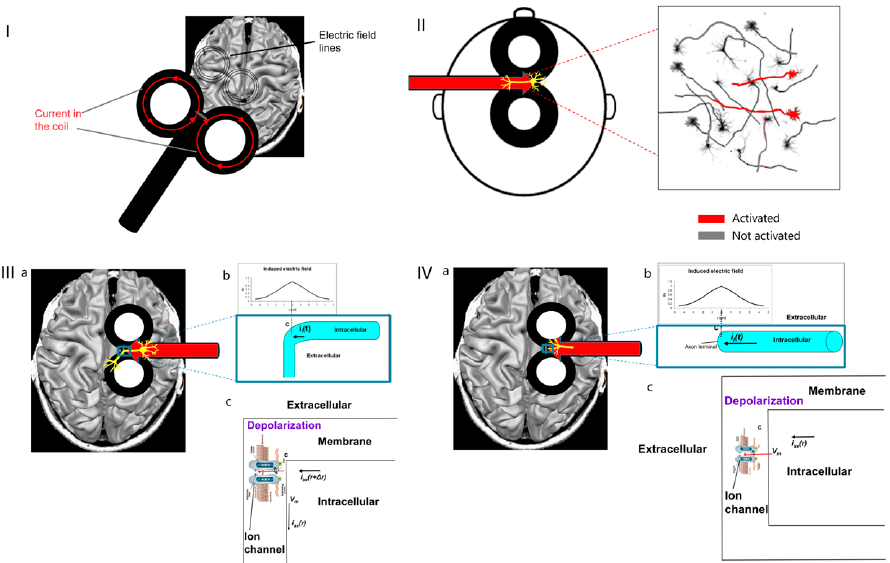
Figure 2. ( I ). Electric field lines induced by a typical figure-8 TMS coil. ( II ). Under the figure-8 central segment, only neurons aligned parallel to the electric field, along the coil axis, are activated (indicated in red). ( III ). Where neurons under the coil center have axon parallel to the induced electric field and bends away from it ( a ), the field is maximal at the bend point ( b ) and leads to transmembrane potential V m across the voltage-gated ion channels ( c ), which are then opened, and action potential is initiated. ( IV ). Where neurons under the coil center have axon parallel to the induced electric field and terminate ( a ), the field is maximal at the axon terminal ( b ) and leads to transmembrane potential V m across the voltage-gated ion channels ( c ), which are then opened, and action potential is